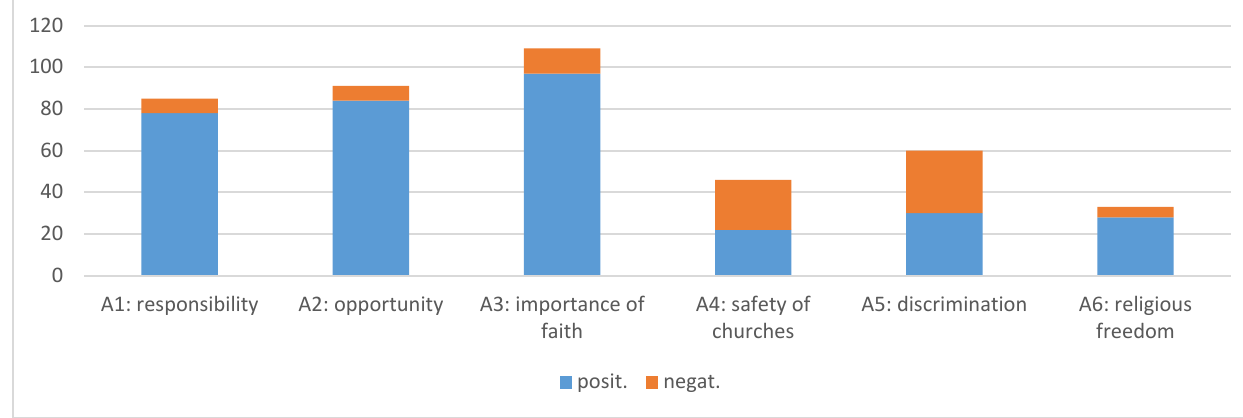
Figure 10. Number of occurrences of all arguments.